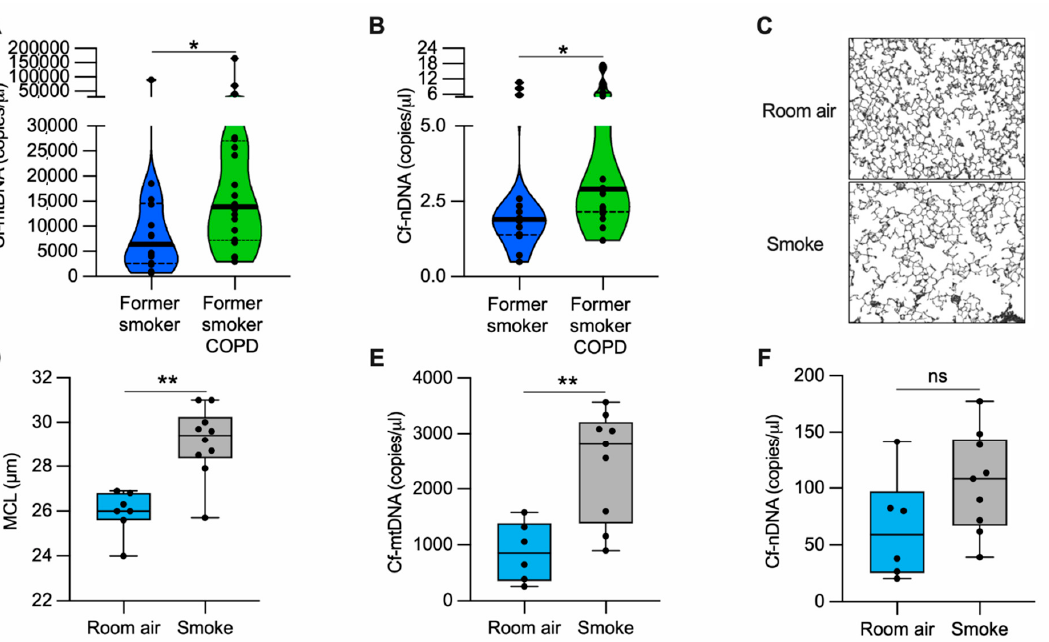
Figure 1. cf-mtDNA is elevated in the plasma of former smokers with COPD and in the serum of a mouse model of emphysema induced by CS exposure. ( A ) Cell-free mitochondrial DNA (cf- mtDNA) and ( B ) cell-free nuclear DNA (cf-nDNA) levels in the plasma of former smokers without airway obstruction ( n = 14) and former smokers with COPD ( n = 20); ( C ) representative images of modified Gill’s stained lung tissue shown in black and white as the threshold for the analysis (original magnification 200 × ); ( D ) mean chord length (MCL) quantification of mice exposed to cigarette smoke ( n = 10) or room air ( n = 7) for six months; ( E ) cf-mtDNA and ( F ) cf-nDNA in the serum of mice exposed to cigarette smoke ( n = 9) or room air ( n = 6) for six months. Data are shown in the ( A , B ) truncated violin or in the ( D – F ) box and whiskers plots, with circles representing individual samples. The bold horizontal bands in the ( A , B ) truncated violin plots represent the median (second quartile), and the dashed bands are the first and the third quartiles. ns, no statistical significance; * p < 0.05 and ** p < 0.01 were determined by an unpaired t